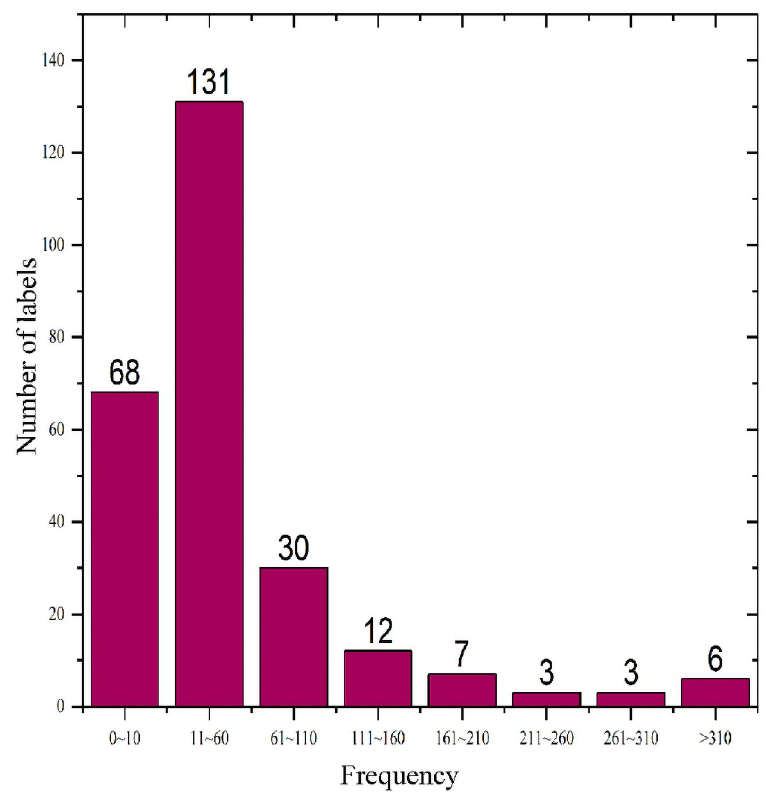
Fig 4. Corel5k dataset label